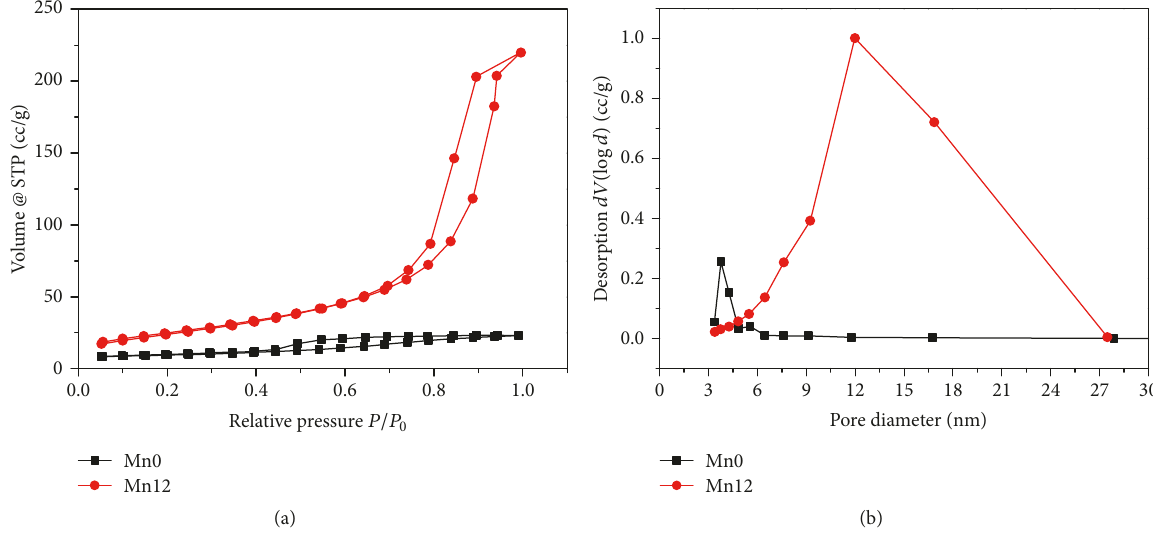
Figure 5: (a) N 2 adsorption/desorption isotherms and (b) pore size distribution for Mn0 (black squares) and Mn12 (red points) samples.